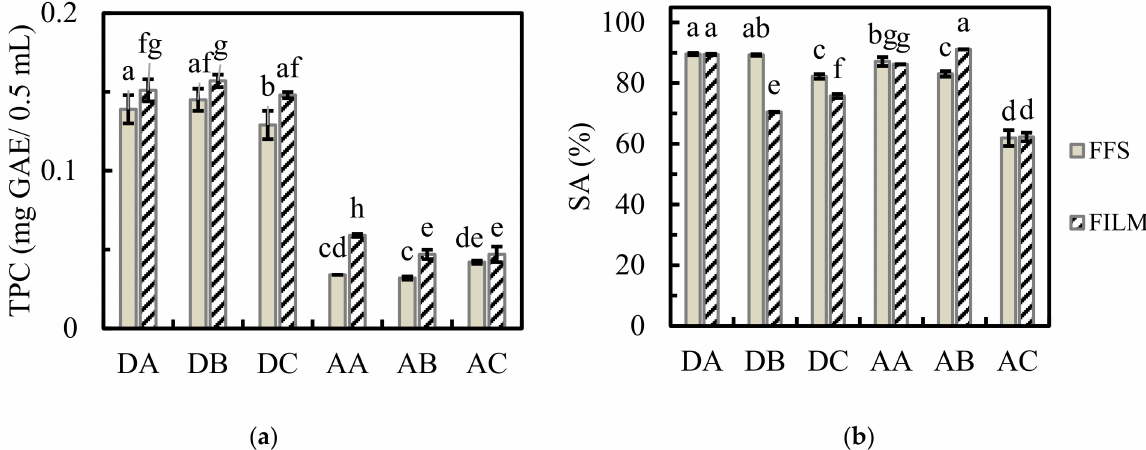
Figure 2. ( a ) Total phenolic content (TPC) and ( b ) antioxidant activity (SA) of film forming solutions (FFS) and films based on dittany (D) or anise (A) infusions and pectins A, B or C. Pectins A and B were extracted from orange peels using MAE (620 W, 1:25 w/v , 3 min) and UMAE (50/850 W, 1:20 w/v , 30/3 min), respectively. Pectin C was a commercial